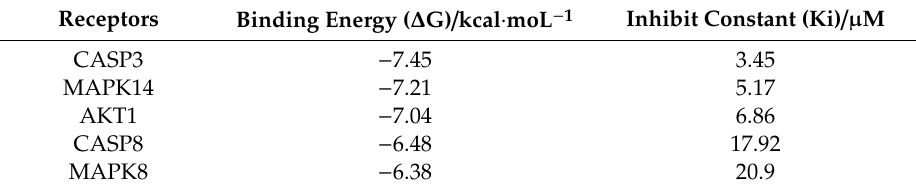
Table 3. Results of molecular docking between stemazole (ST) and the predicted